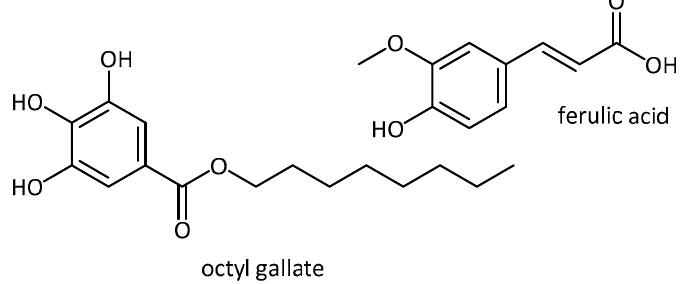
Figure 13. Natural products used in combination treatment.